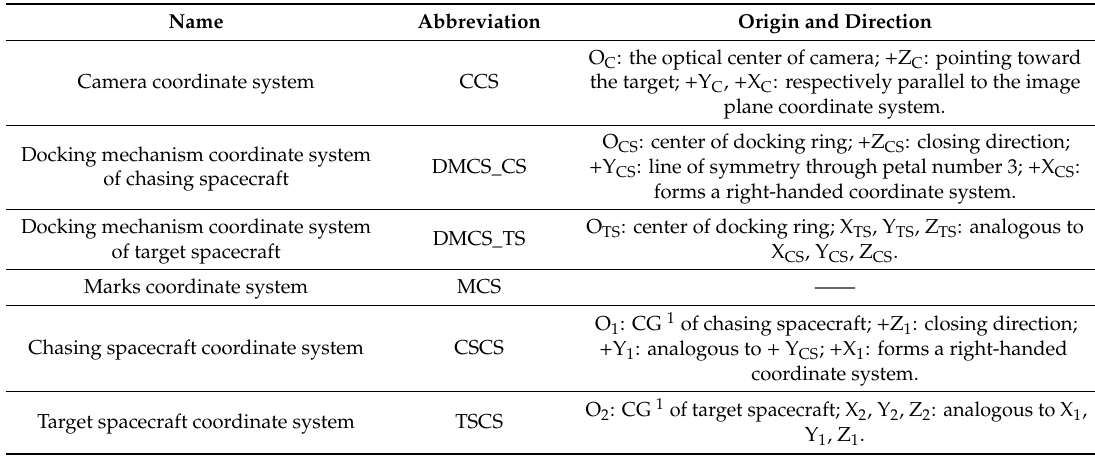
Table 1. Coordinate systems used for low impact docking (as shown in Figure